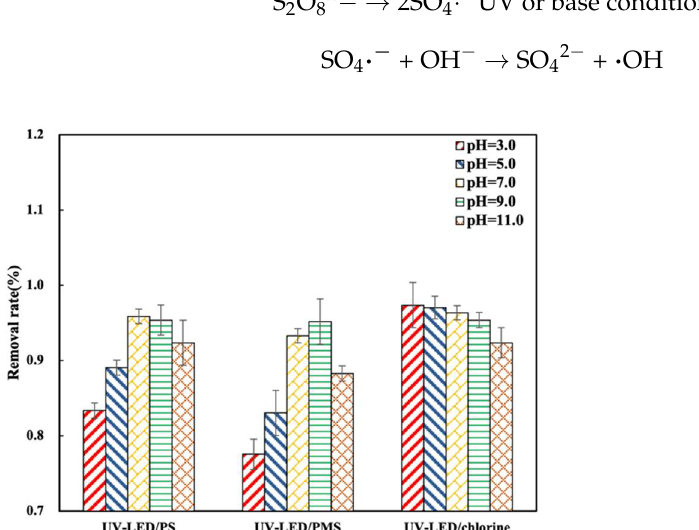
Figure 3. The removal rate of CAP by UV-LED/H 2 O 2 , UV-LED/PS, UV-LED/chlorine under different pH. Conditions: [CAP] 0 = 5.0 mg/L, [PS] = [H 2 O 2 ] = [NaClO] = 0.5 mM, wavelength = 280 nm and lamp power I 0 = 2.4 mW/cm 2 , t = 60 min.